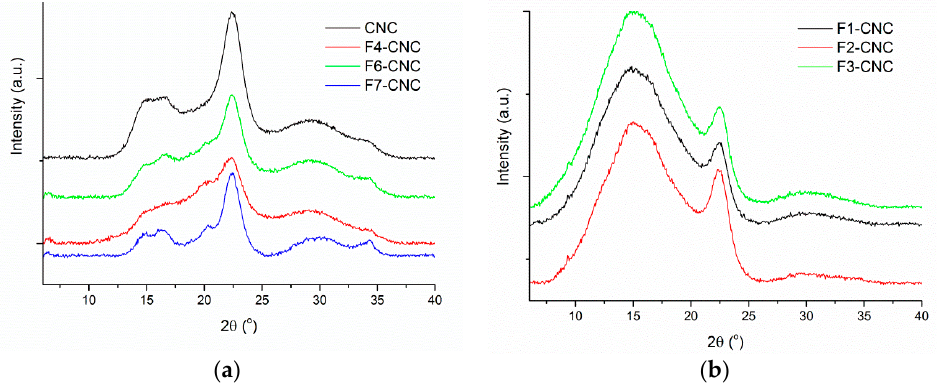
Figure 4. Wide angle X-ray scattering (WAXS) of F-CNCs under optimized reaction conditions ( a ) and under excess of silane ( b ).